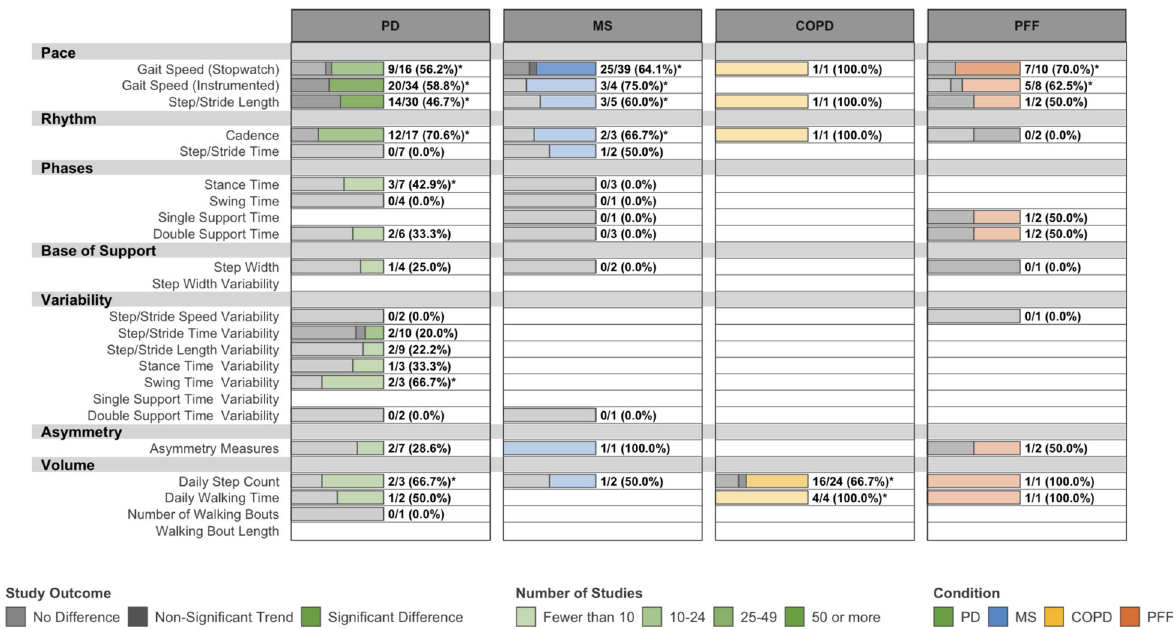
Fig. 6 Responsiveness of DMOs used as primary or secondary endpoints when a studied intervention was effective. PD Parkinson ’ s disease, MS multiple Sclerosis, COPD chronic obstructive pulmonary disease, PFF proximal femoral fracture. Data are presented as: Number of studies with statistically signi fi cant differences between groups/Total studies (%). This map may overestimate the responsiveness of DMOs, which were occasionally used as sole primary outcomes (i.e., gait speed and step count), since negative results could be due either to the DMO ’ s responsiveness or to the intervention ’ s ef fi cacy. DMOs known to be highly intercorrelated were grouped (i.e., step length and stride length), and all DMOs were organized according to previously established domains of gait. *Proportion of studies exceeds the expected false- positive rate as determined by Bernoulli hypothesis testing and Benjamini – Hochberg